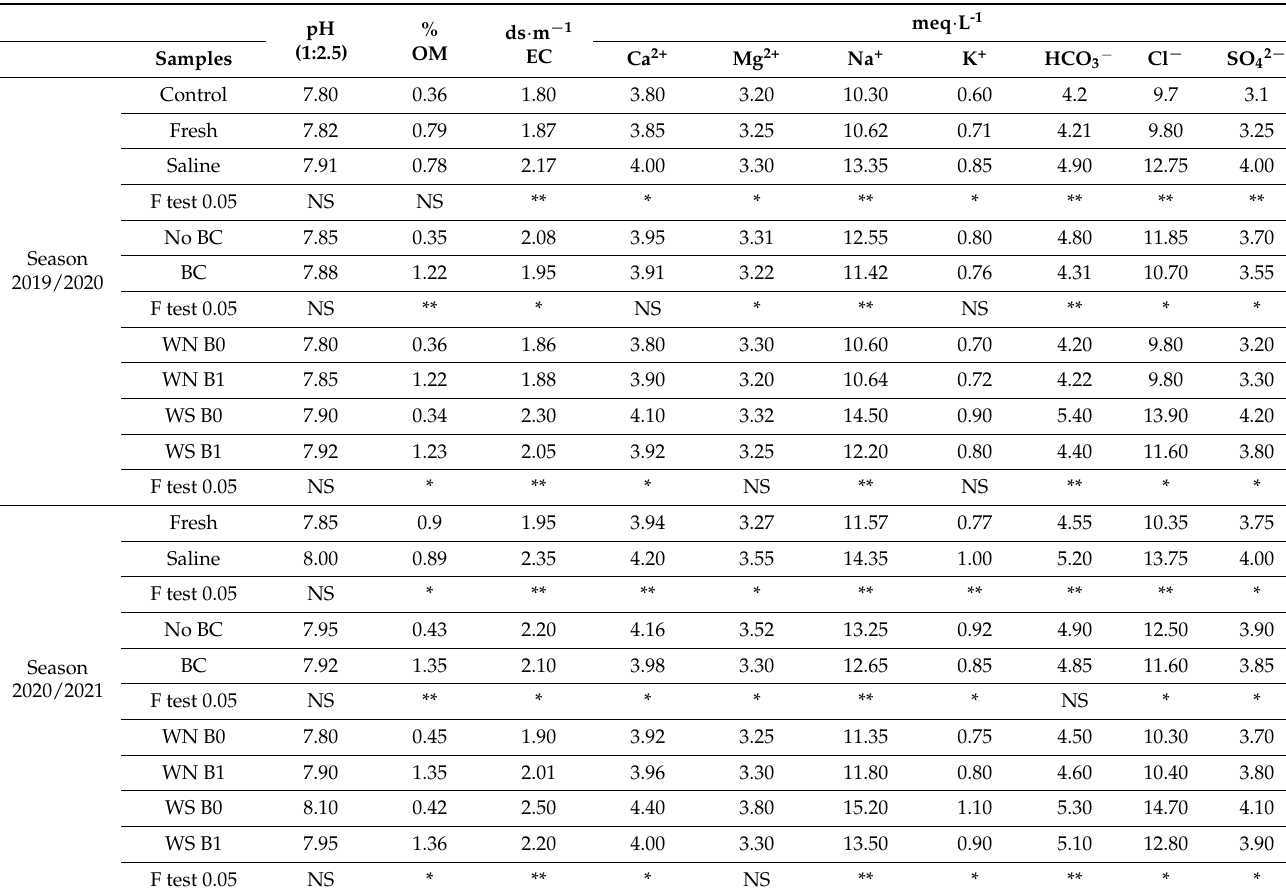
Table 3. Some properties of soil samples under study seasons 2019/2020 and